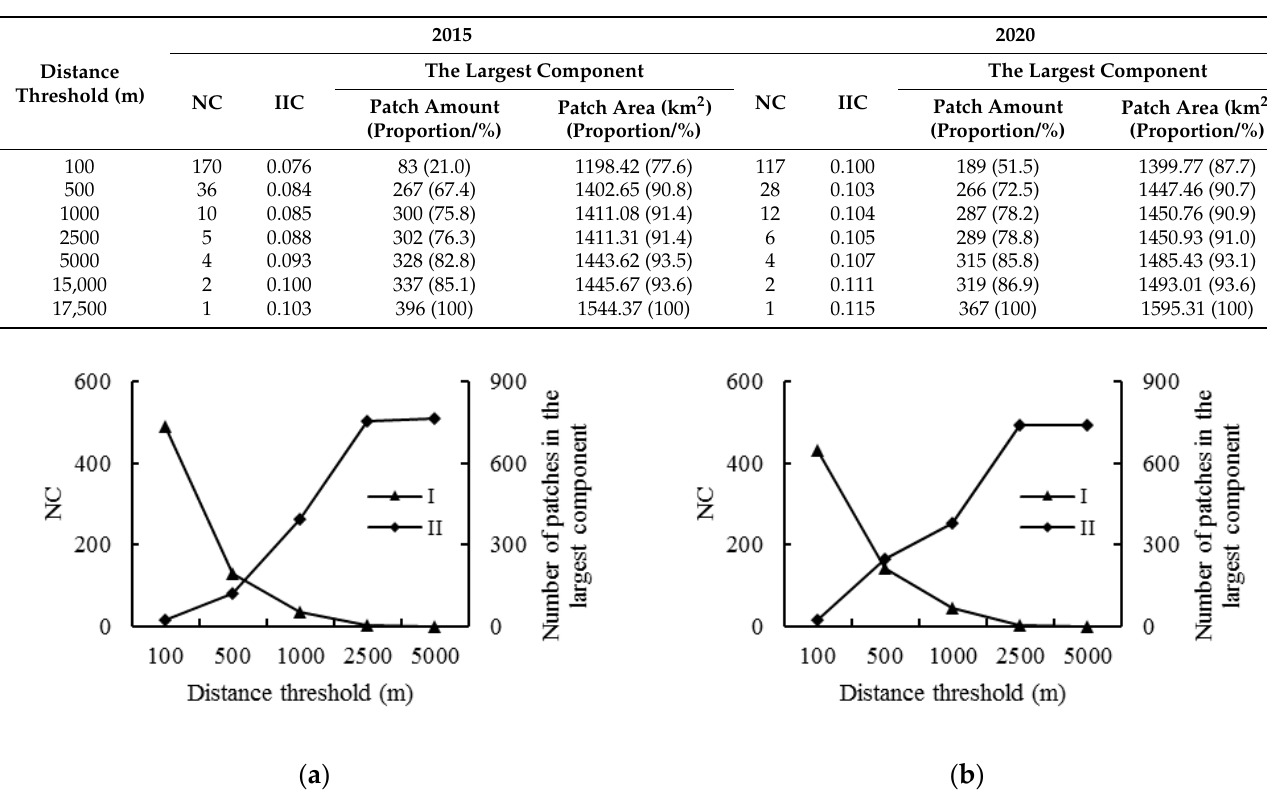
Figure 4. NC (I) and the number of patches in the largest component (II) of forest in hills under different distance thresholds in 2015 ( a ) and 2020 ( b ).